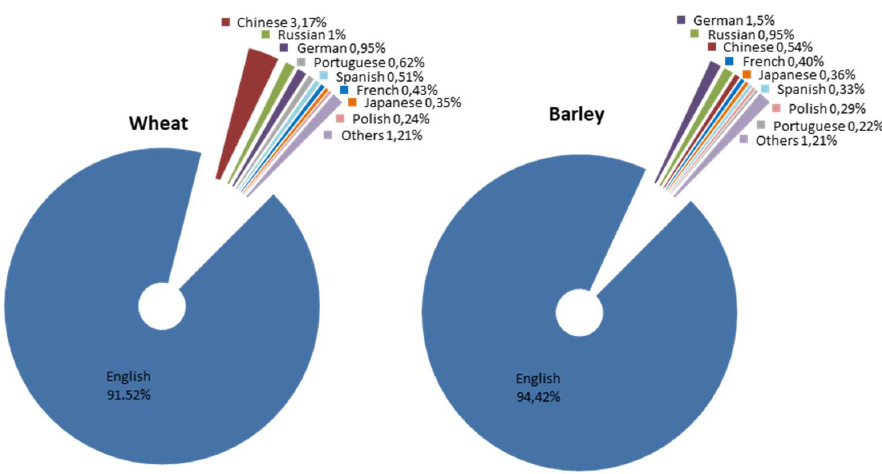
Figure 4. Languages of scientific output in the wheat and barley research fields.